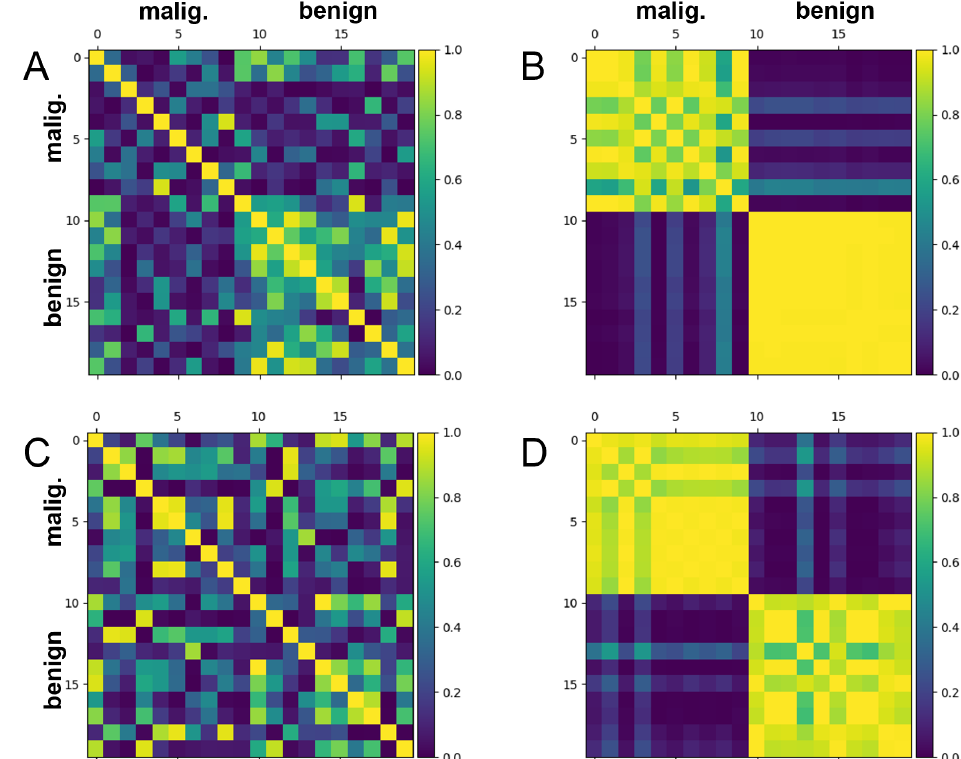
Figure 6. Gram matrices depicting mutual data overlap in Hilbert space (i.e., | (cid:104) x | x (cid:48) (cid:105) | 2 ) for 10 benign and 10 malignant train and test samples from the breast cancer dataset. In each case, PCA was used to reduce the number of features (and thus the number of trainable linear parameters). The stronger the separation between the purple tiles (benign) and the yellow tiles (malignant), the better the model’s ability to classify. A random seed of ’1’ was used for the train-test split of this data. The PennyLane software package was used to train the embeddings [40]. ( A ) Mutual data overlap in Hilbert space for test set datapoints at optimization step 0, using ( x 1 , x 2 ) values generated from 8 principal